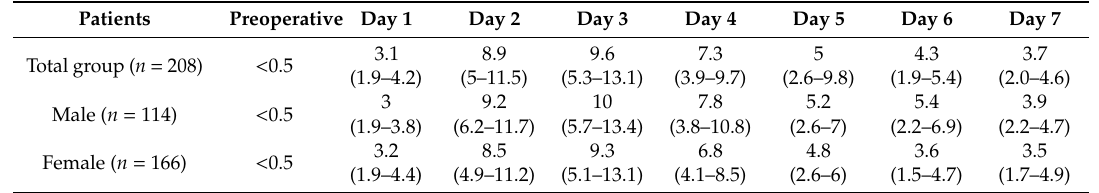
Table 2. Overview of postoperative C-reactive protein levels in mg / dL following shoulder arthroplasty. Mean values and interquartile range in the